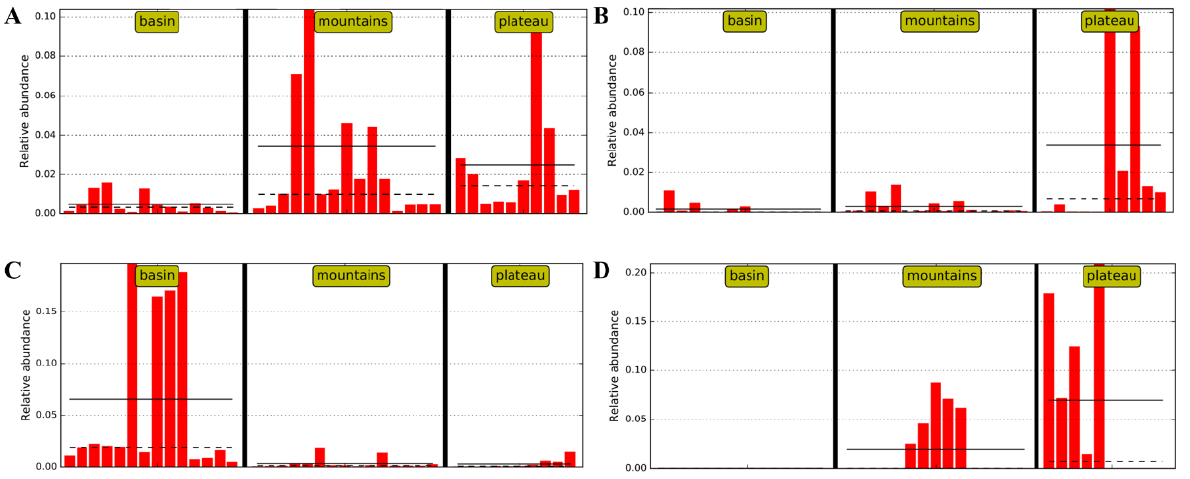
Figure 4. Significantly different genera through LefSe analysis of different abundant taxons among three regions of Sichuan bacon: ( A ) Lactobacillus , ( B ) Lactococcus , ( C ) Brochothrix , and ( D ) Pseudomonas .